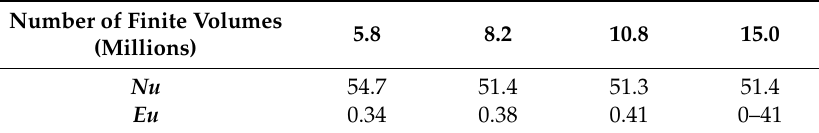
Table 3. The mesh independence test.